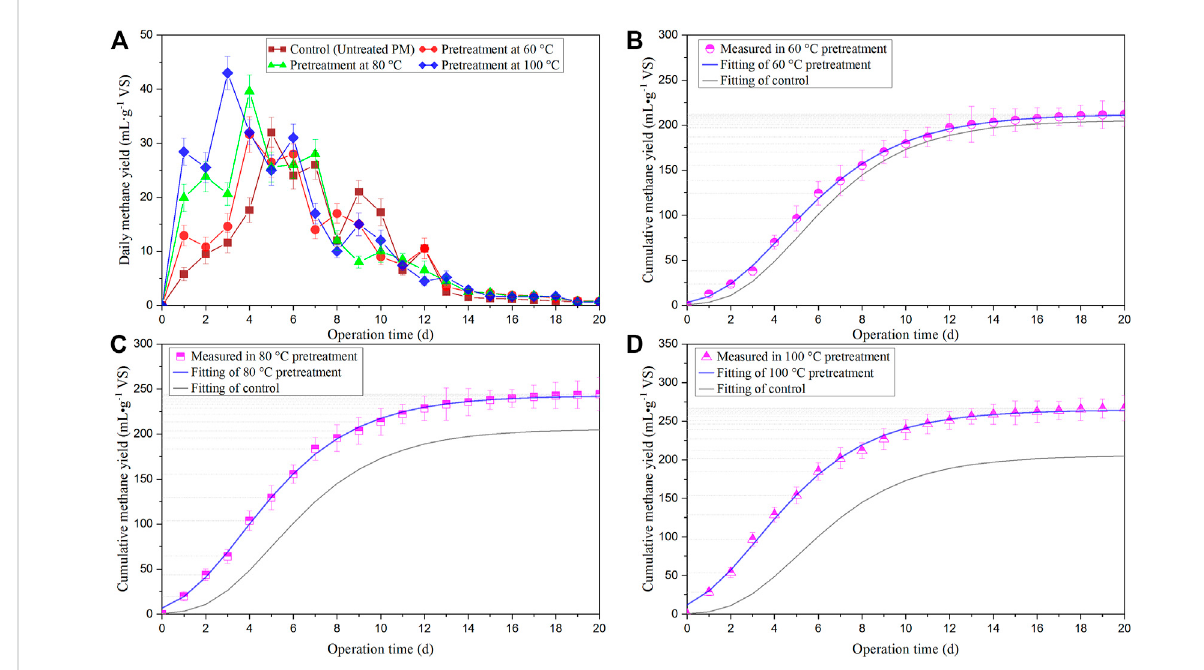
FIGURE 3 Daily methane yields (A) and the measured cumulative methane yields with their fi tting curves (B – D) in the BMP test of PM